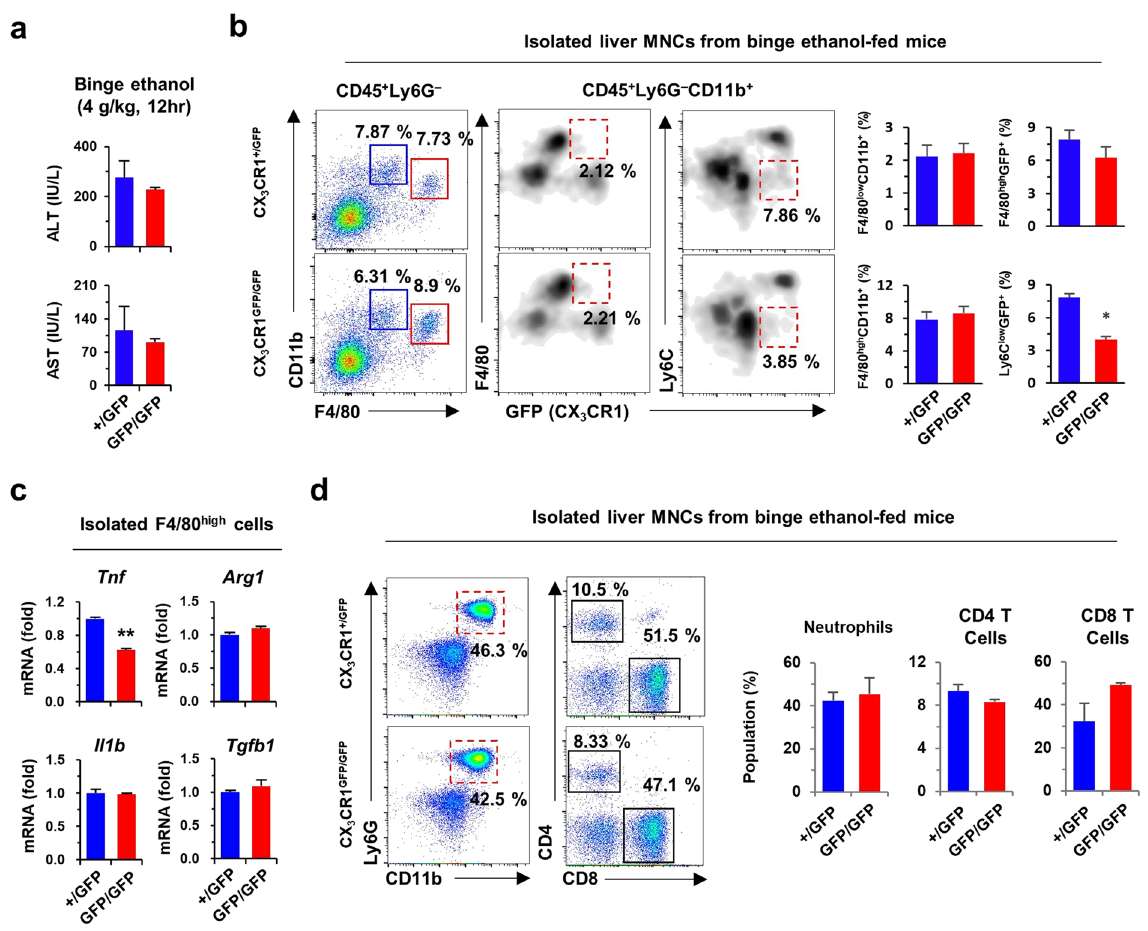
Figure 6. CX 3 CR1 deficiency attenuates acute alcoholic liver injury. To induce acute alcoholic liver injury, CX 3 CR1 + /GFP (n = 4) and CX 3 CR1 GFP/GFP (n = 4) mice were fed 4 g/kg ethanol (binge ethanol drinking). ( a ) Serum levels of ALT and AST were measured in binge ethanol-fed mice. ( b , c ) Isolated liver MNCs and F4/80 high cells from binge ethanol-fed mice were subjected to flow cytometry and qRT-PCR analysis, respectively. Data are expressed as the mean ± SEM. * p < 0.05, ** p < 0.01 compared to corresponding controls. ( d ) Isolated liver MNCs from binge ethanol-fed mice were subjected to flow cytometry. The results represent two independent